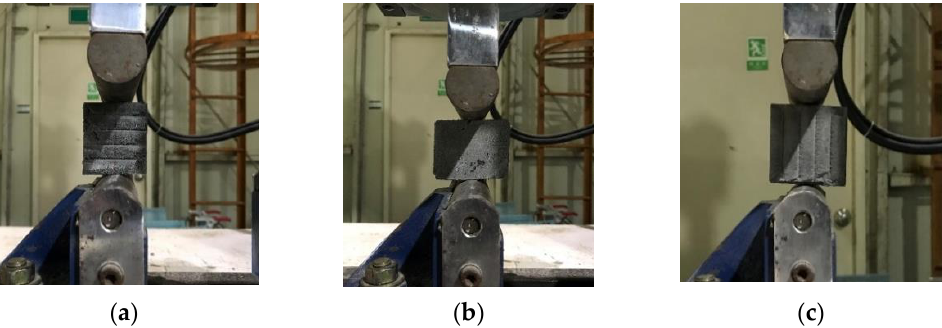
Figure 16. Splitting tensile strength tests under three loading directions. ( a ) Loading direction I; ( b ) Loading direction II; ( c ) Loading direction III.